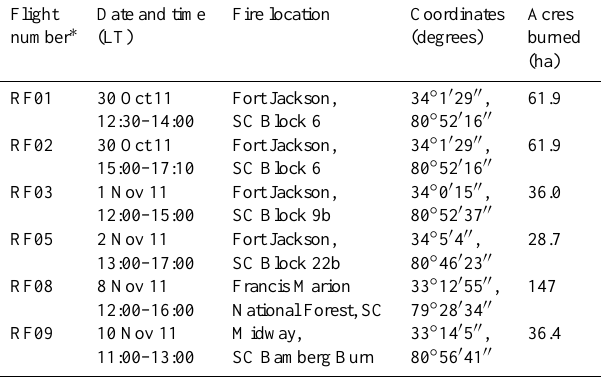
∗ RFmeansresearchflight.ForRF04thePILSsystemwasnotoperational.RF06wasaflightover Columbiatoexamineurbanemissionsanddidnotsampleanyburning.RF07hadlimitedaccesstoa prescribedburninGeorgetown,SC,duetoitbeingconductedonprivateland,leadingtofew smoke-impactedfractioncollectorsamples.RF09isdenotedasRF09AandRF09Bthroughoutto indicatethetwodifferentendsofthisburn.